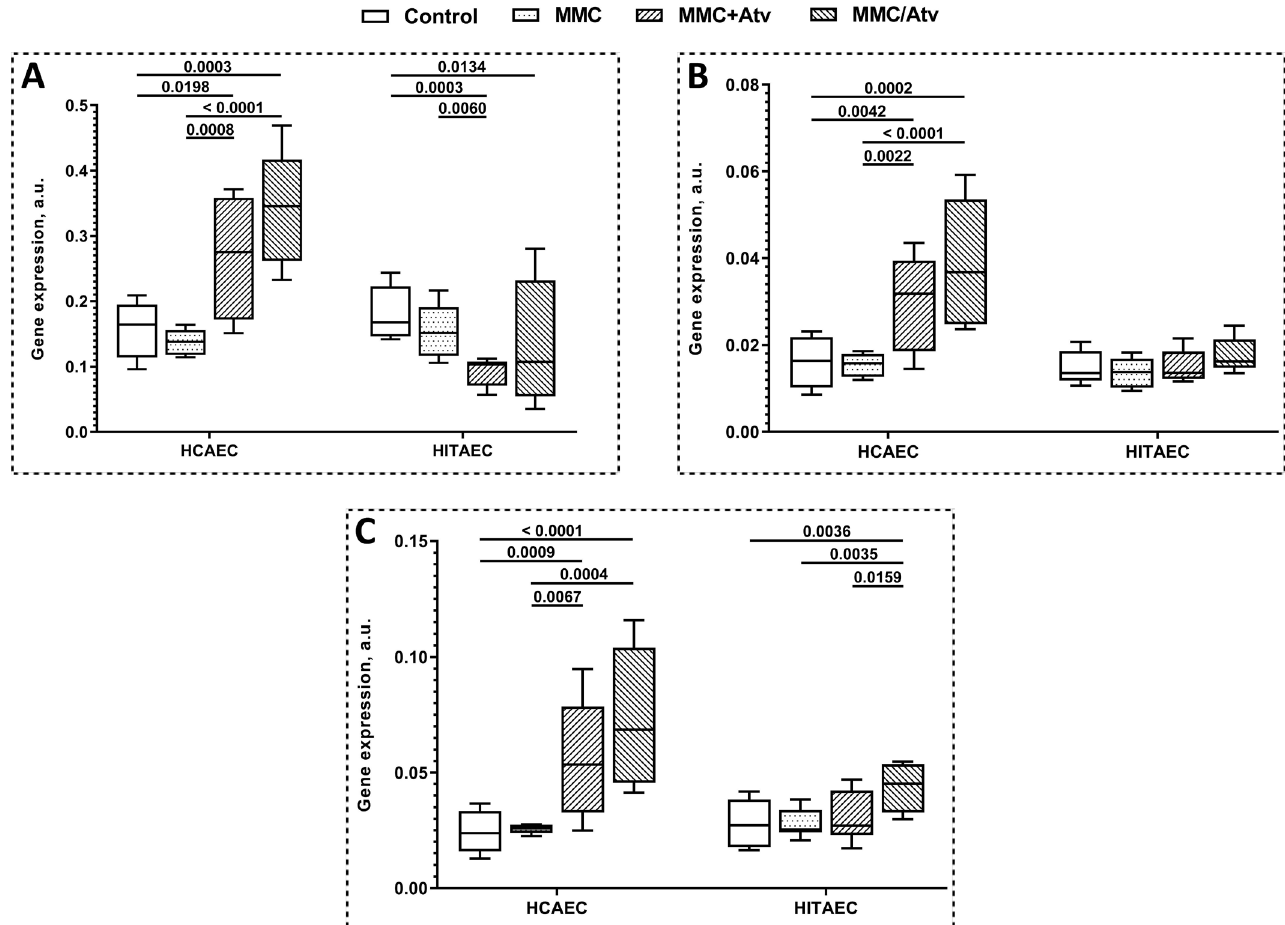
Figure 3. Expression of DDB1 ( A ), ERCC4 ( B ), and ERCC5 ( C ) in endothelial cells (MMC, mitomycin C; Atv, atorvastatin; HCAEC, human coronary artery endothelial cells; HITAEC; human internal thoracic endothelial cells; MN, micronuclei; NBUDs, nuclear buds; NPBs, nucleoplasmic bridges).